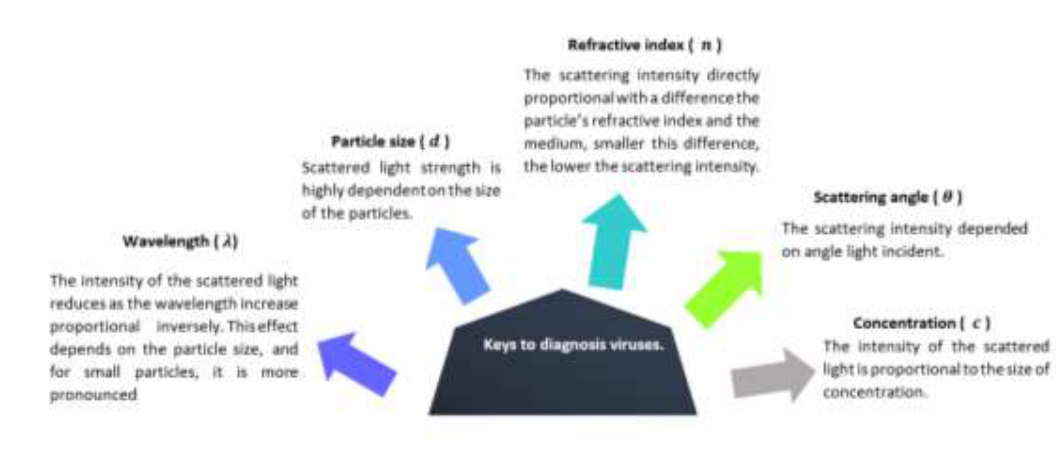
Figure 3 . A schematic description of parameters affecting light